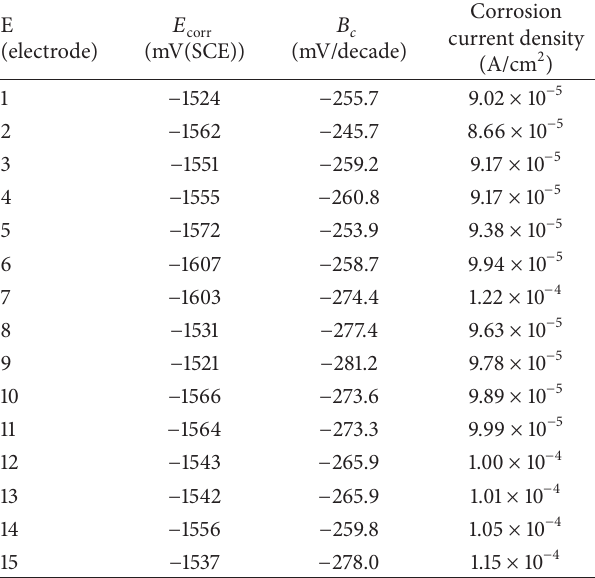
Table 1: The fitting parameters of polarization curves of array electrodes under fluid flow condition with the flow velocity of 5.31